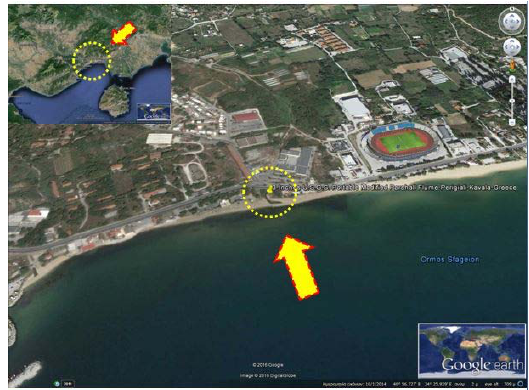
Figure 1. Parshall flumes and V ‐ Notched weir gauging station, Perigiali Stream area, Kavala city,